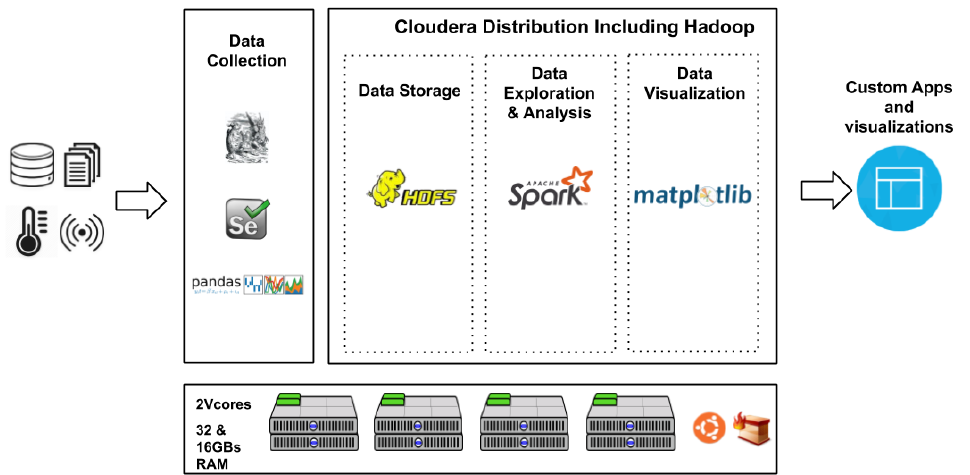
Figure 2. The distributed architecture utilized to collect, store and analyze the data, adapted from